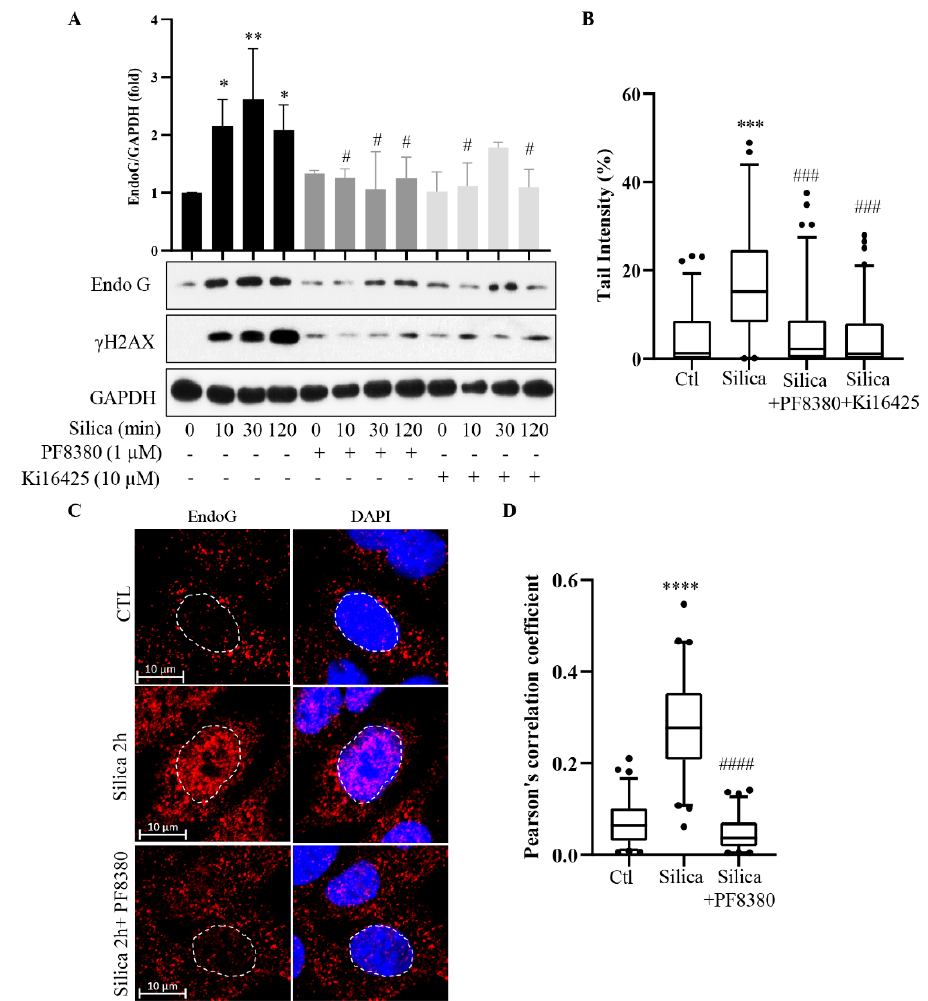
Figure 4. ATX inhibition reduces silica-induced EndoG translocation to nucleus and DNA damage. 16HBE cells pretreated with the ATX inhibitor PF8380 (1 µ M) or the LPA inhibitor Ki16425 (10 µ M) for 1 h, and then exposed to silica (5 µ g/cm 2 ) for times indicated. In ( A ), cell lysates were analyzed for EndoG and γ H2AX by Western blotting. In ( B ), cells from A were analyzed for DNA damage using Comet assay. In ( C ), representative confocal images of 16HBE cells with EndoG (red) and nuclear (blue) staining. Controls (CTL) and cells exposed to silica for 2 h +/ − PF8380 are shown. In ( D ), EndoG in DAPI stained areas is quantified. Bars in A show means ± SD. Bars in ( B , D ) show median with 95% confidence interval. All experiments were performed at least in triplicate. * p < 0.05, ** p < 0.01, *** p < 0.001, **** p < 0.0001 compared to control. # p < 0.05, ### p < 0.001, #### p < 0.0001 compared to silica exposure, as determined by ANOVA